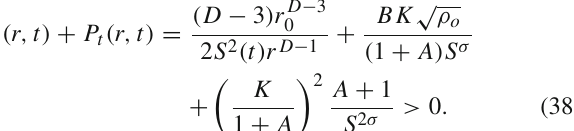
throat when the wormhole neck radius is same as that of the ≥ 4 − 3 K 2 √ ESU if S 2 ρ o . The transverse NEC is always 0 3 BK